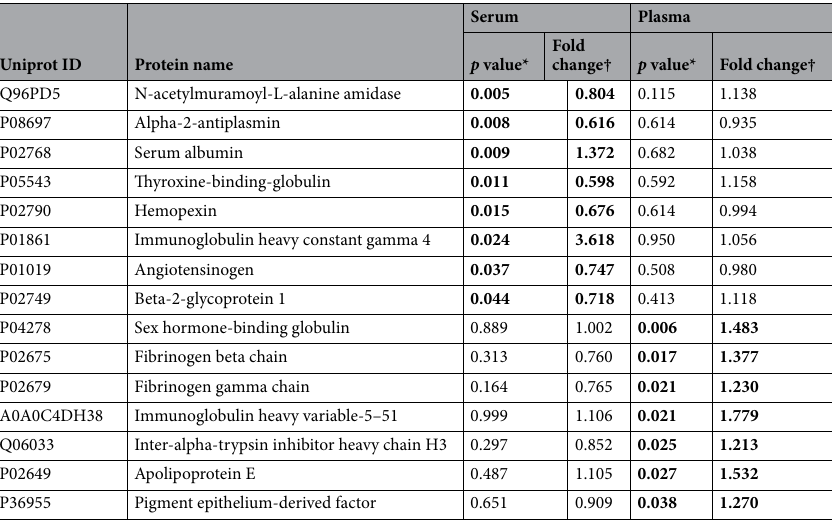
Table 3. Serum and plasma protein candidates for biomarkers related to the intracranial hemorrhage after rtPA treatment in ischemic stroke patients. † The fold change represents the change of protein concentration between the patients with and without ICH, *Any changes in protein concentrations with p value < 0.05 were considered significant, no matter the extent of the concentration change.